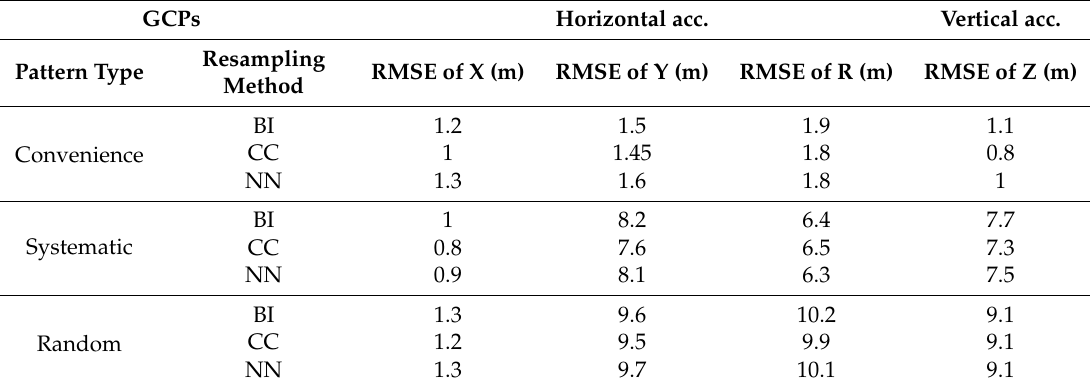
Table 4. Vertical and horizontal accuracy assessments for different patterns of ground control point (GCP) selection with three resampling methods. GCPs Horizontal acc. Vertical